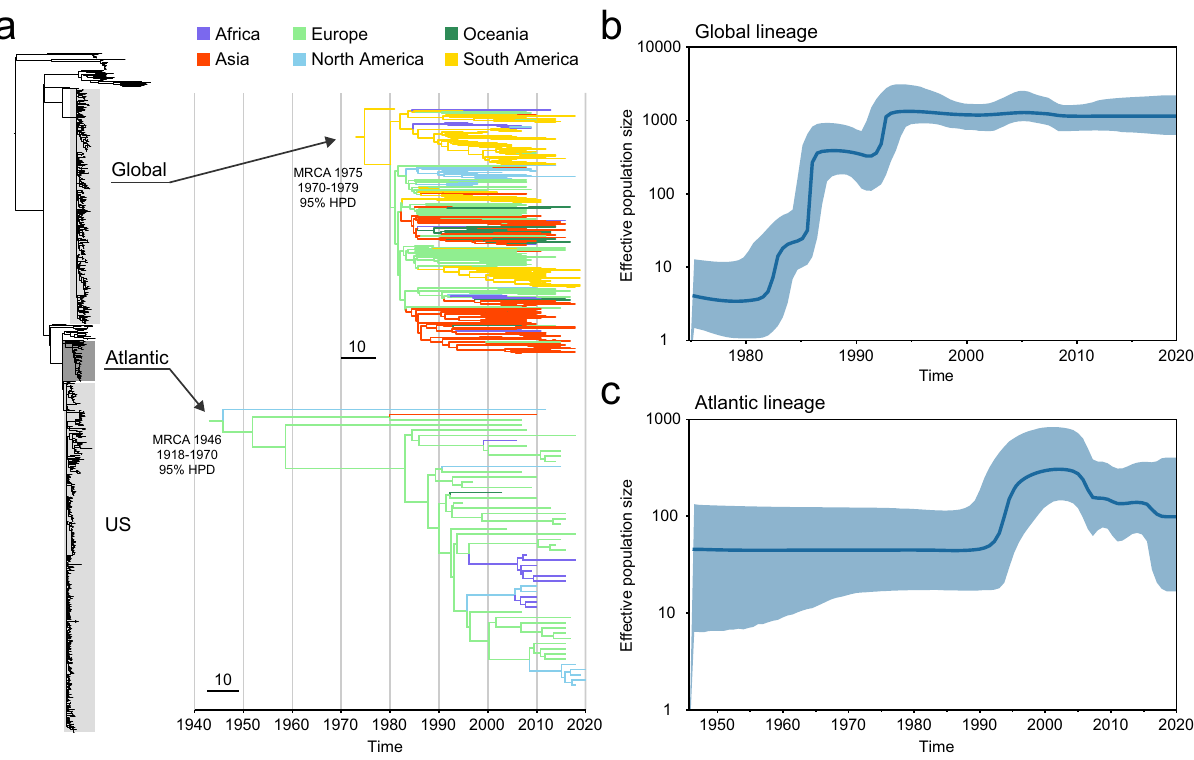
Fig. 5 Phylodynamic analyses of the Global and the Atlantic lineages. a Maximum clade credibility trees and phylogeographical inference. The inferred median MRCA age of each lineage is shown with 95% HPD. MRCA, most recent common ancestor; HPD, highest posterior density. Terminal branches are color coded by the isolates ’ continent of origin. Internal branches are colored to indicate the predicted geographical origin with the highest posterior probability value inferred using maximum-likelihood ancestral trait reconstruction. The scale bars indicate 10 SNPs. b , c Bayesian skyline plots showing the historical changes of the effective population size of poultry Salmonella Enteritidis populations in the Global and the Atlantic lineages. Blue lines represent the medians of estimated effective population sizes. Blue shadings indicate the upper and lower bounds of the 95% HPD